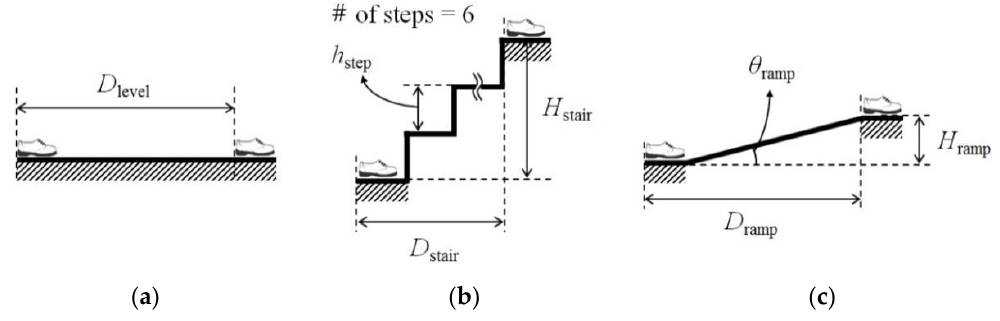
Figure 20. Five types of ambulation tests: (( a ) level walk (LW), ( b ) stair ascent (SA), ( c ) stair descent (SD), ( d ) ramp ascent (RA), and ( e ) ramp descent (RD)) on three different terrains for performance validation of the proposed method. Ramp ascent and descent were conducted on three ramps with different slopes to validate the performance of the slope estimation.